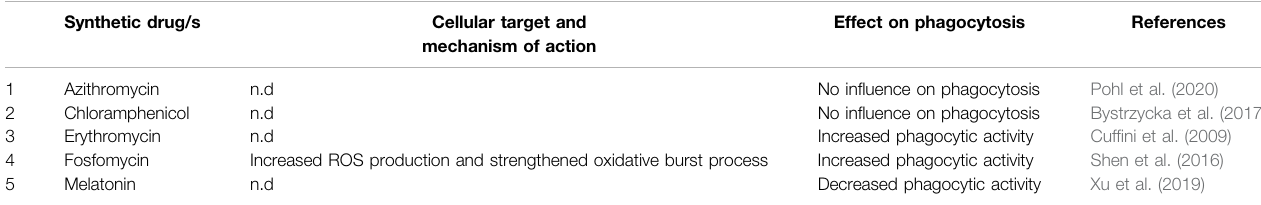
TABLE 3 | List of selected synthetic drugs with documented impact on phagocytosis. Synthetic